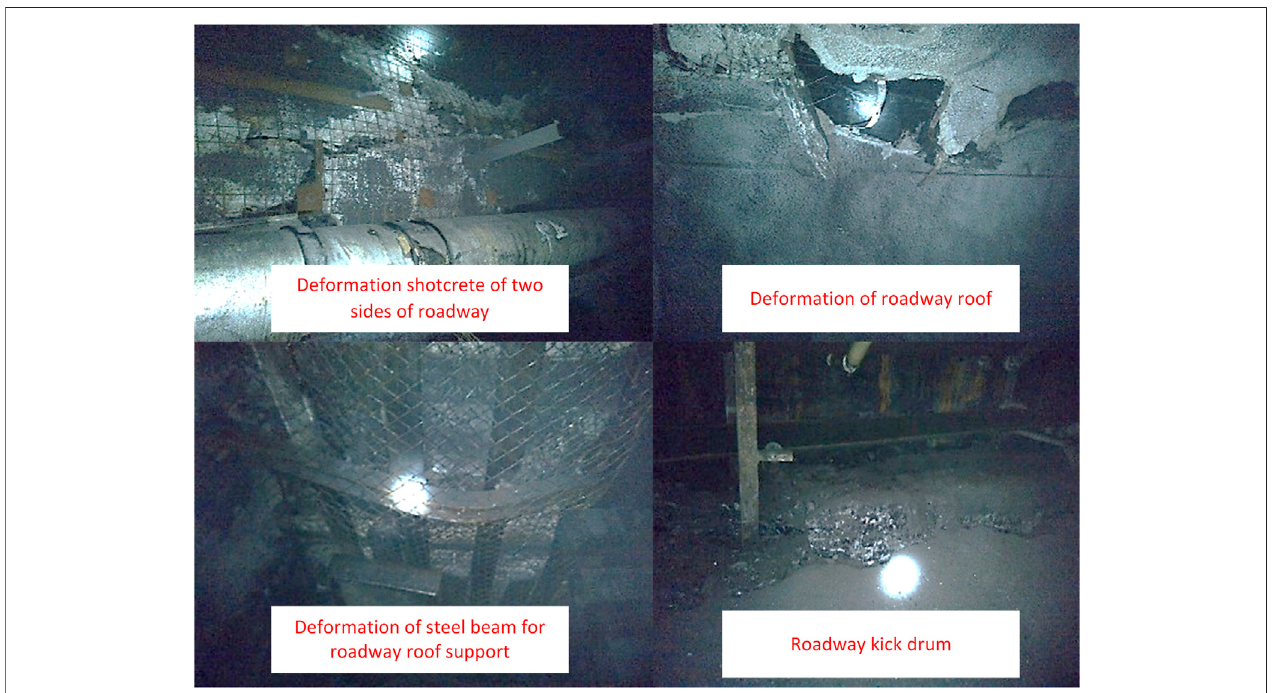
FIGURE 3 | Photographs of the rockburst event.